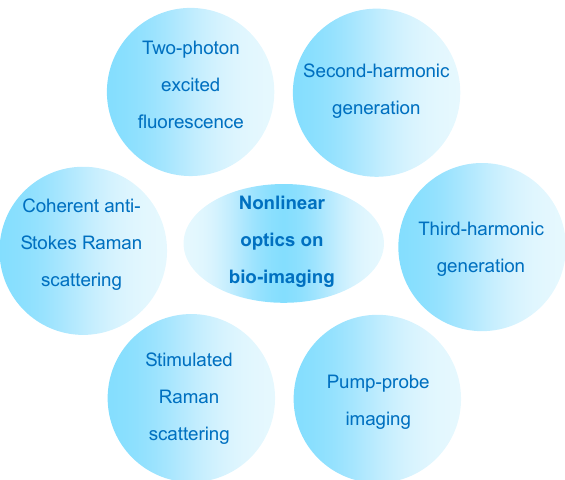
Fig. 2 | Main nonlinear optical modalities applied to bioimaging .